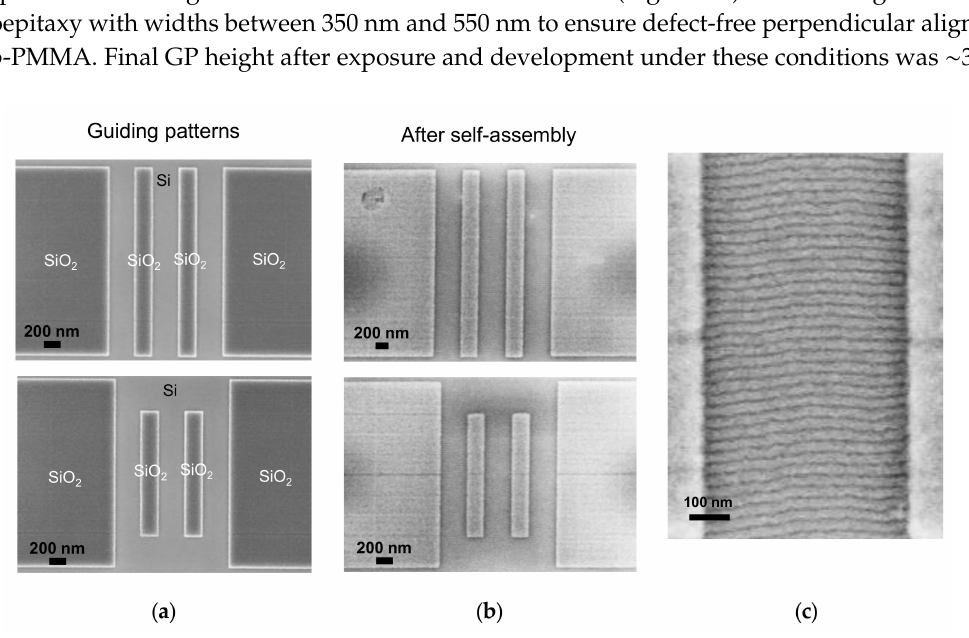
Figure 4. ( a ) Scanning electron microscopy (SEM) top-view micrographs of HSQ GPs after development; ( b ) SEM top-view micrographs after graphoepitaxy within GPs. Parallel PS-b-PMMA lamellae (28 nm pitch) can be observed perpendicular to the walls and bottom of the trenches; ( c ) SEM top-view micrograph of a 500 nm trench after graphoepitaxy of PS-b-PMMA (28 nm